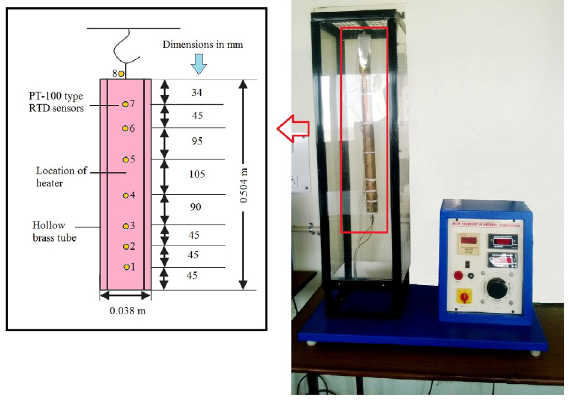
Figure 3. Natural convection equipment used for the experiments using air as a